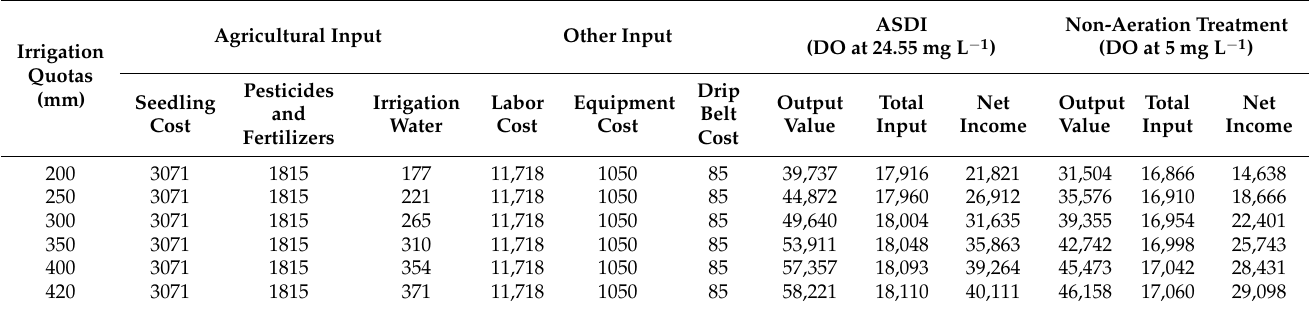
Table 8. Economic benefits under multiple irrigation quotas (USD ha − 1